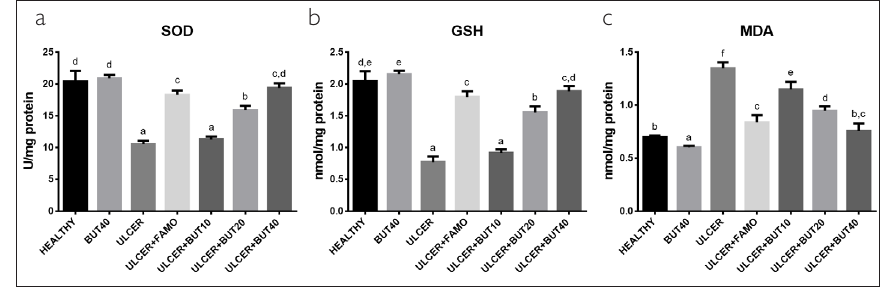
Figure 2. a-c. (a) Stomach tissue SOD activity, (b) GSH level, and (c) MDA level. Means with the same letter are not significantly different; means with different letters indicate significant differences between the groups according to the Duncan test (p <0.05). Results are mean±SD. N=6 animals per group